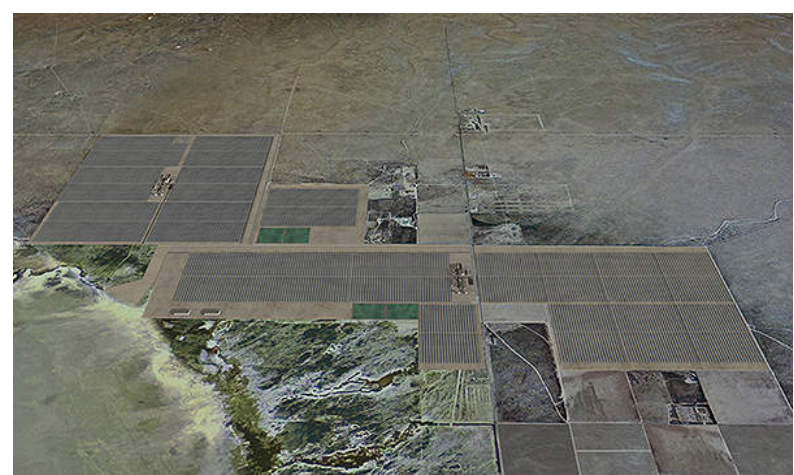
Figure 1. Mojave solar project: Courtesy of Atlantica